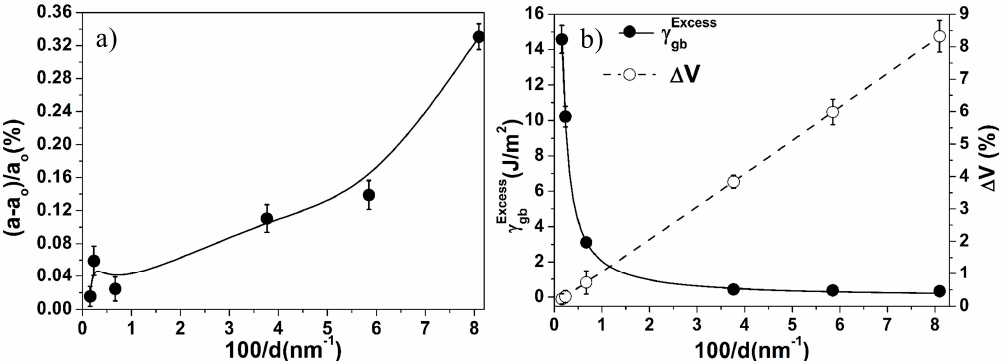
Figure 4. Effect of crystallite size on ( a ) change in lattice parameter and ( b ) excess GB interfacial energy ( γ (cid:2917)(cid:2912)(cid:2889)(cid:2934)(cid:2913)(cid:2915)(cid:2929)(cid:2929) ) and excess free volume ( Δ V) at the grain boundary of Fe–10Cr–3Al alloy powder.